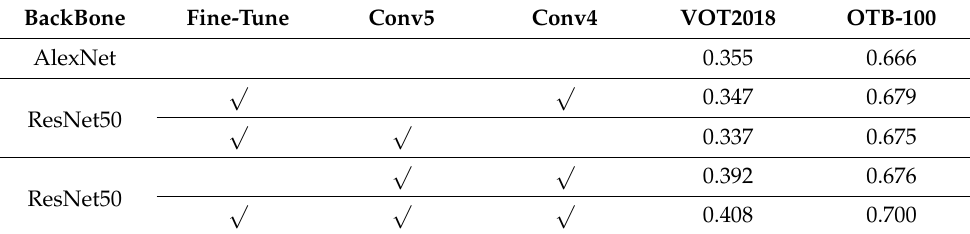
Table 6. Ablation experiments of our approach on two datasets. Fine-tune denotes that the network model is offline-trained.